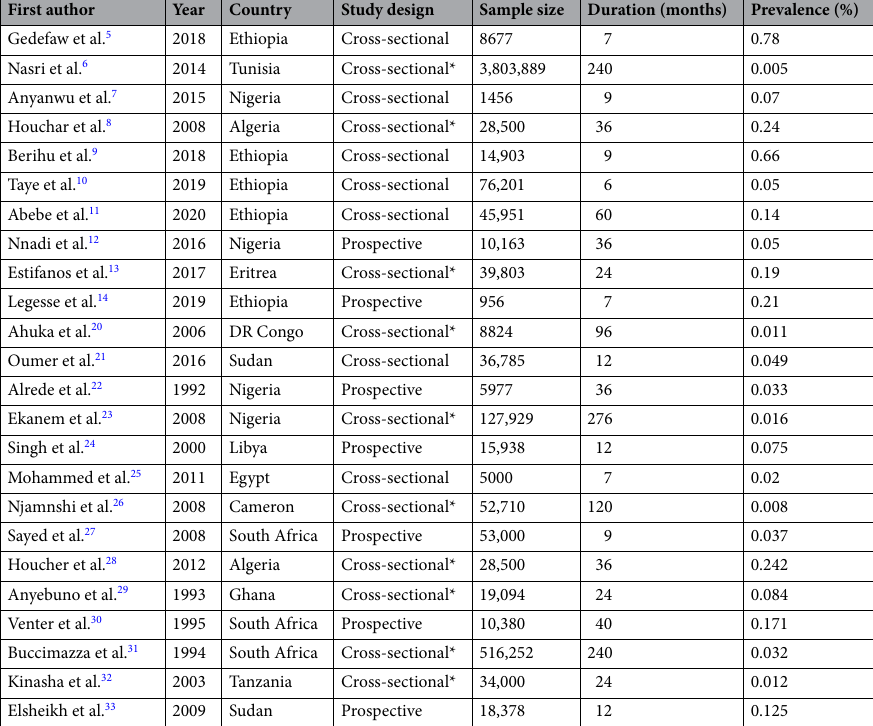
Table 1. The characteristics of original studies included in the systematic review and meta-analysis, 2020. Key: *Cross-sectional study design with a retrospective review.